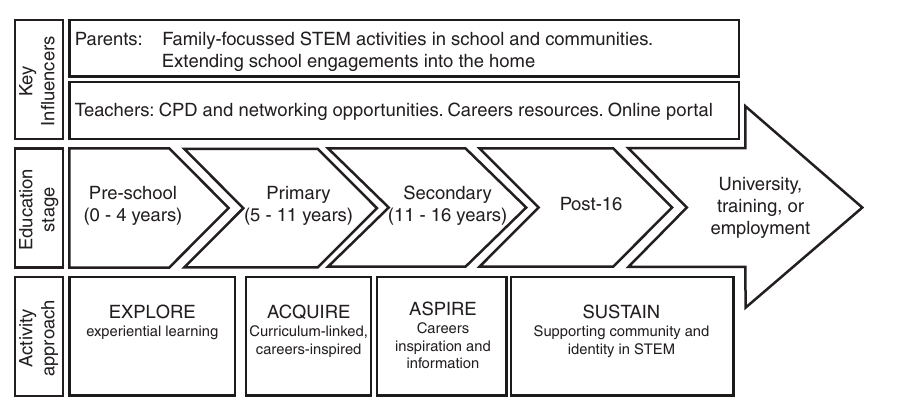
Figure 3: Diagram summarizing the educational journey of a child, their key influencers, and the changing nature of activities required during that time. From Davenport et al.